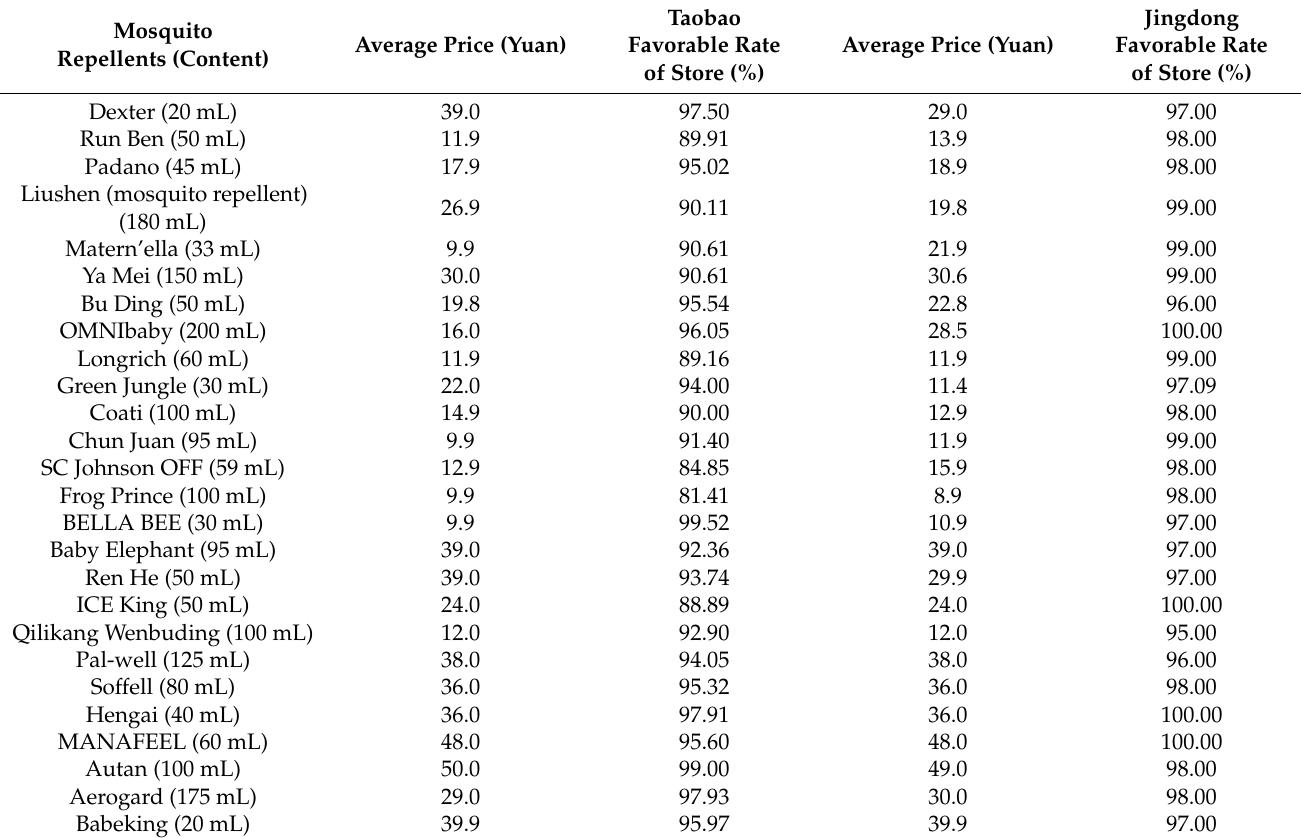
Table 4. Price and favorable rate of mosquito